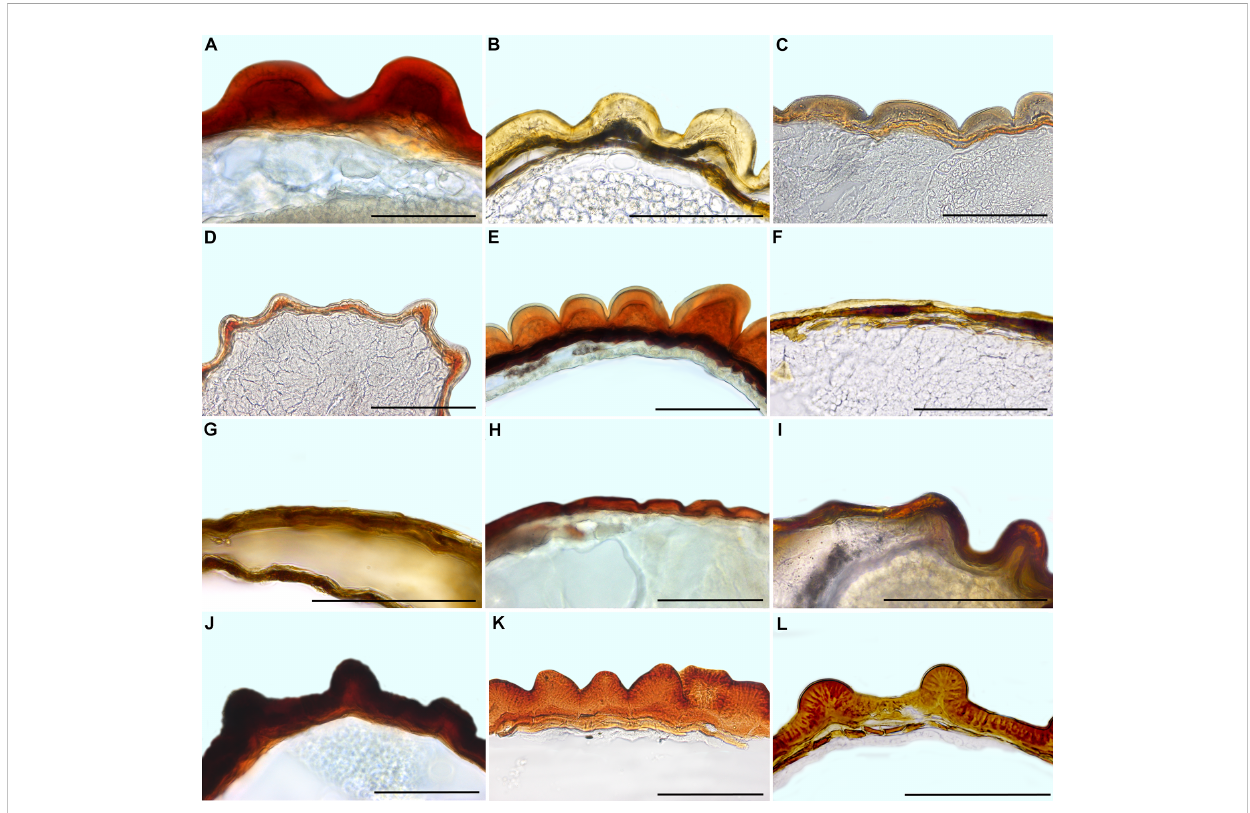
FIGURE 8 Seed coat cross-sections of selected Mesembryanthemoideae (A – F) and Aizooideae (G – L) species. (A) Mesembryanthemum cordifolium , (B) M. aitonis , (C) M. crystallinum , (D) M. nodi fl orum , (E) M. rabiei , (F) M. nucifer , (G) Tetragonia echinata , (H) Gunniopsis papillata , (I) Gunniopsis calva , (J) Aizoanthemopsis hispanica , (K) Aizoon paniculatum , (L) Aizoanthemum mossamedense. Scale bar – 100